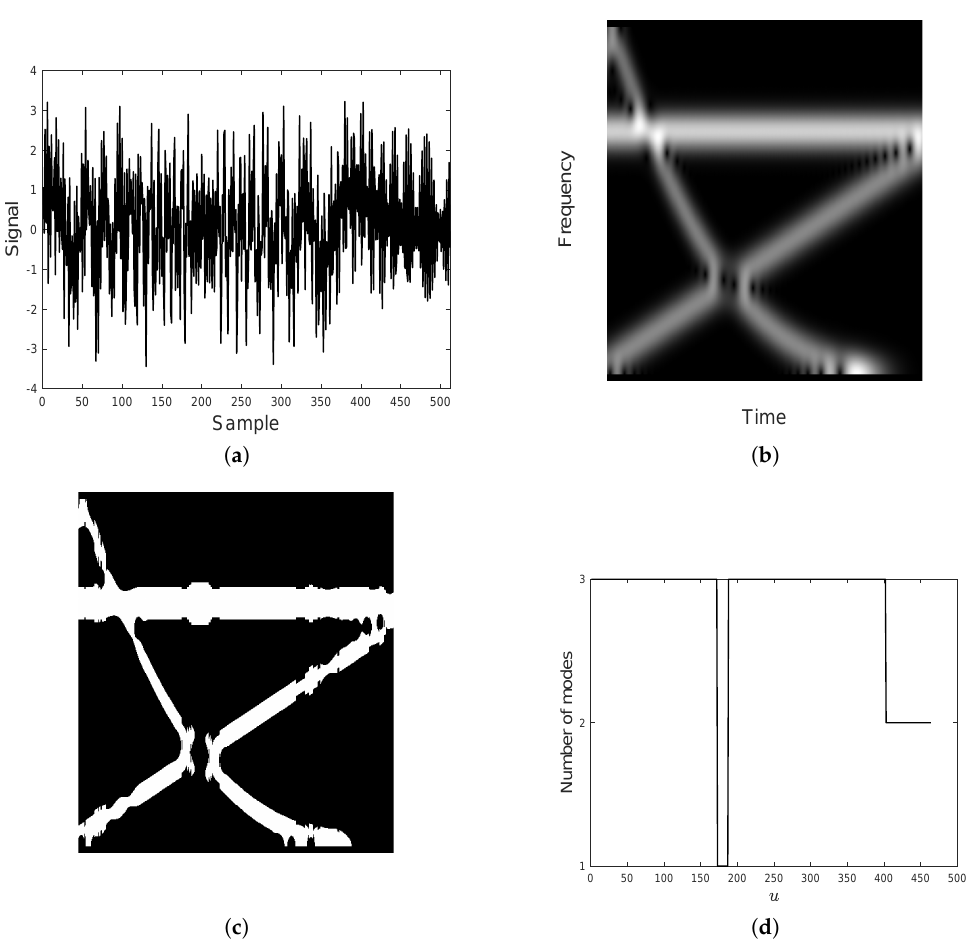
Figure 23. ( a ) Three-component FM signal. ( b ) Spectrogram. ( c ) Binary map derived from ( b ). ( d ) Estimated number of modes.